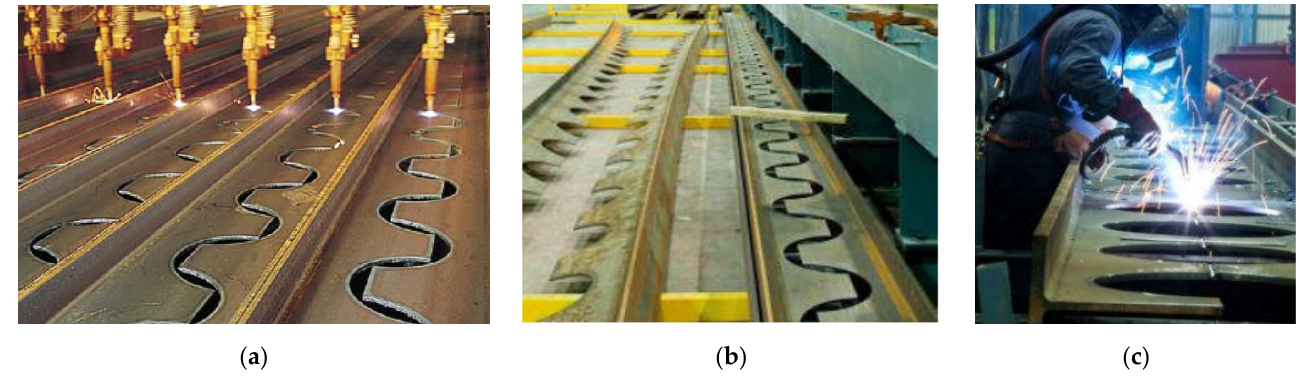
Figure 2. Cellular beams manufacturing process [6,7]: ( a ) Cutting; ( b ) Parting; ( c ) Welding.